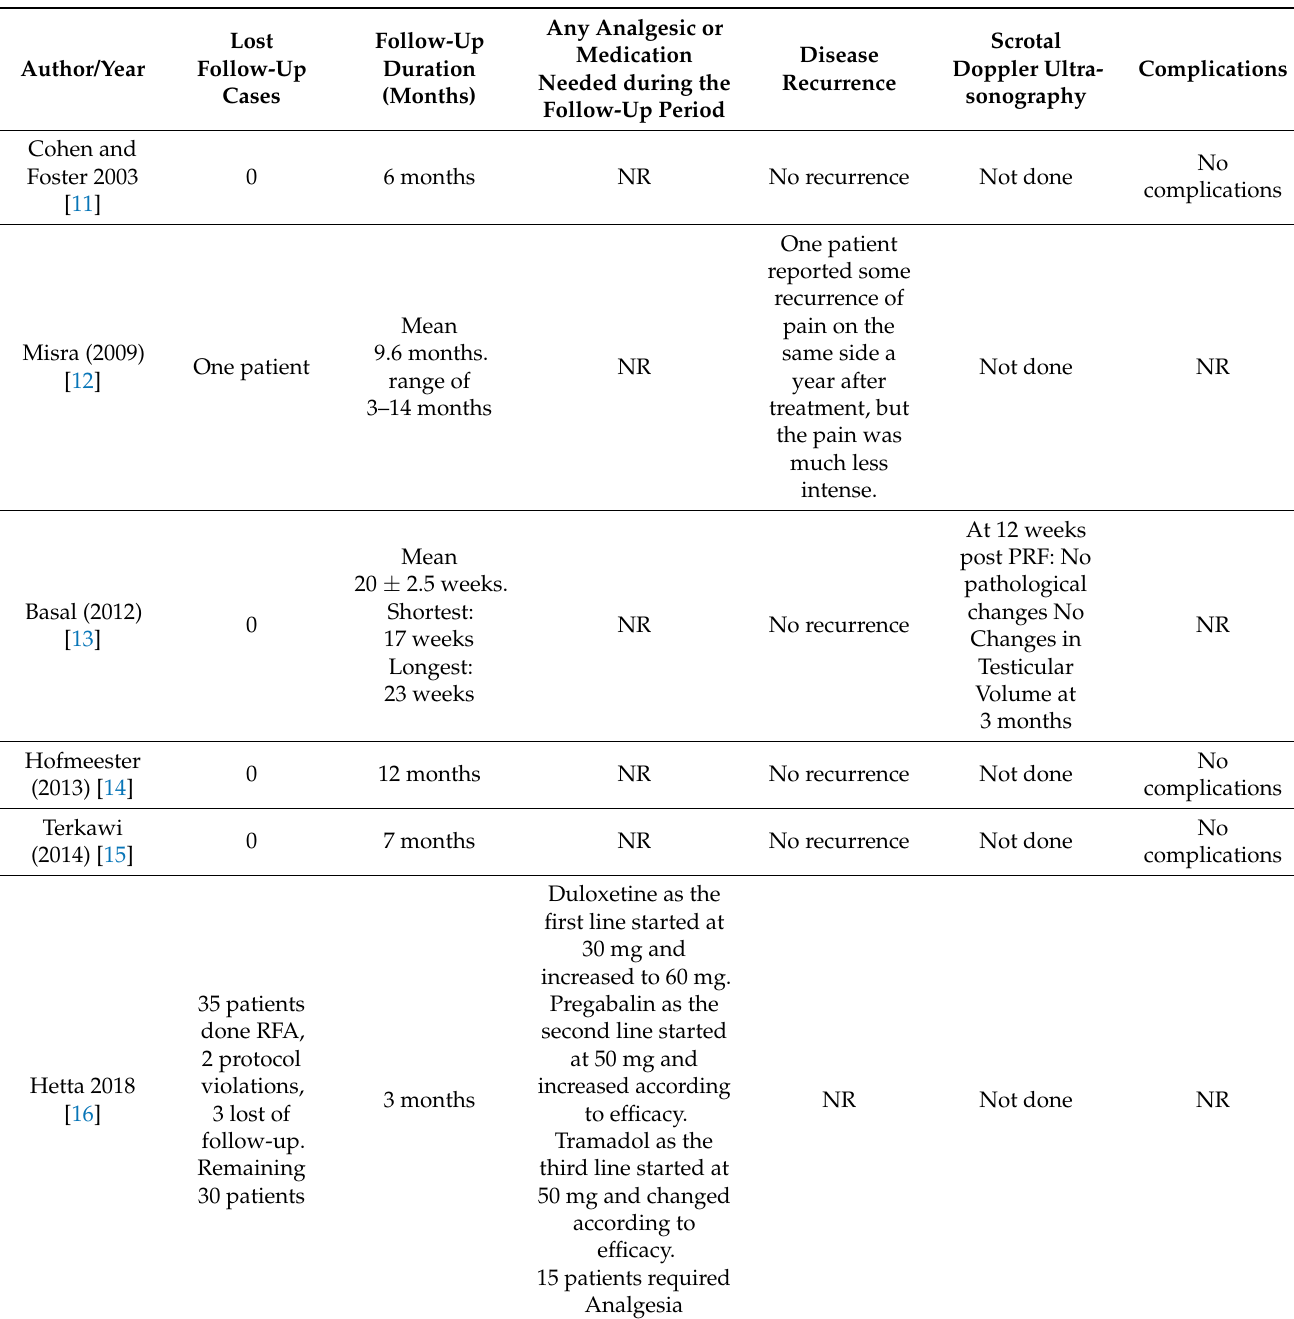
Table 6. Follow-up protocol after pulsed radio-frequency therapy for